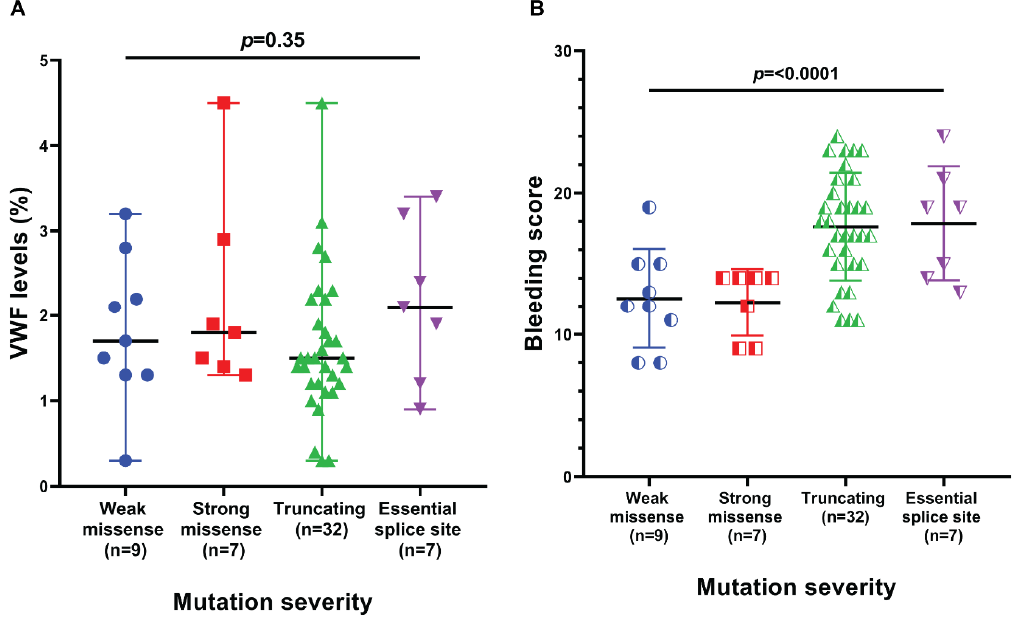
Figure 2. Genotype–phenotype correlations between VWF mutation severity and ( A ) VWF antigen levels, and ( B ) bleeding score in Pakistani vWD patients.